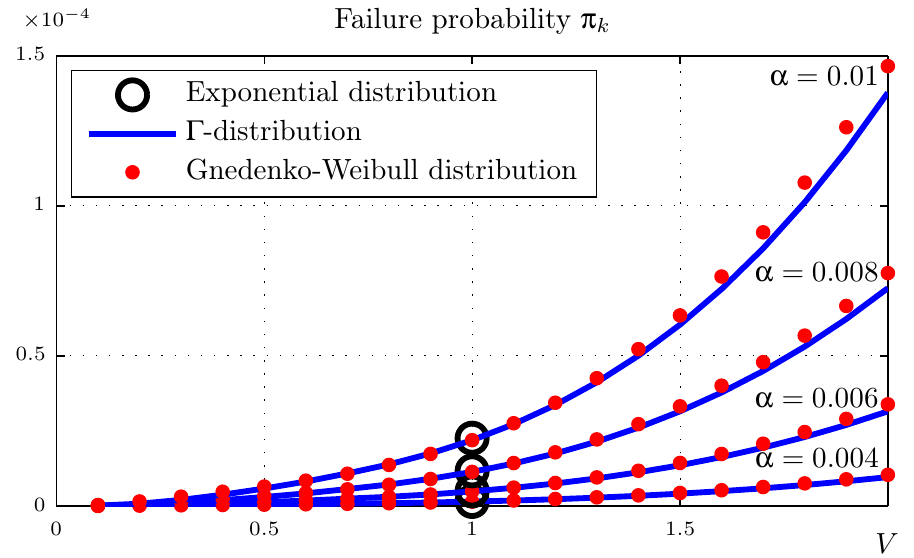
Figure 2. Probabilities of failure of the pipeline sections (“3-out-of-4”) for b = g = 1